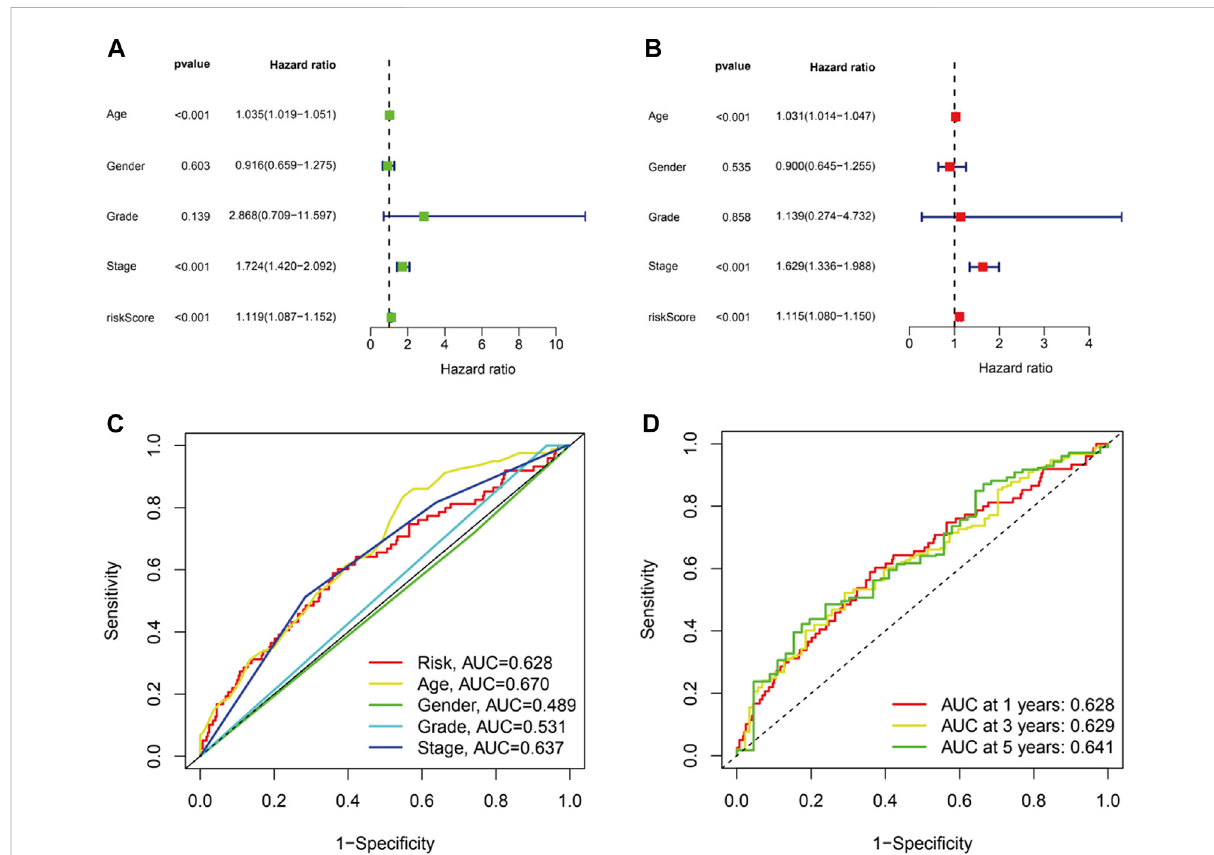
TheprognosticvalueoftheCRLsinBCpatients.Univariate (A) andmultivariate (B) independentprognosticanalysistoexploretheriskscorewas independently related with OS. (C) .ROC curve analysis was utilized to compare the predictive accuracy between the risk model and various clinical features. (D) .ROC curves for 1-, 3-, and 5-year survival